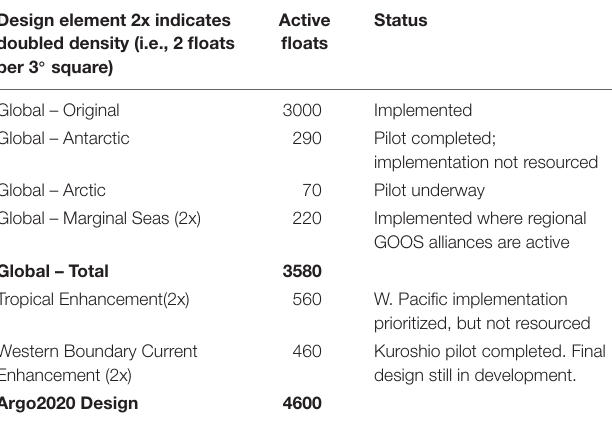
TABLE 1 | Summary of the Argo2020 design, including the required number of active floats and the present status of elements. Design element 2x indicates doubled density (i.e., 2